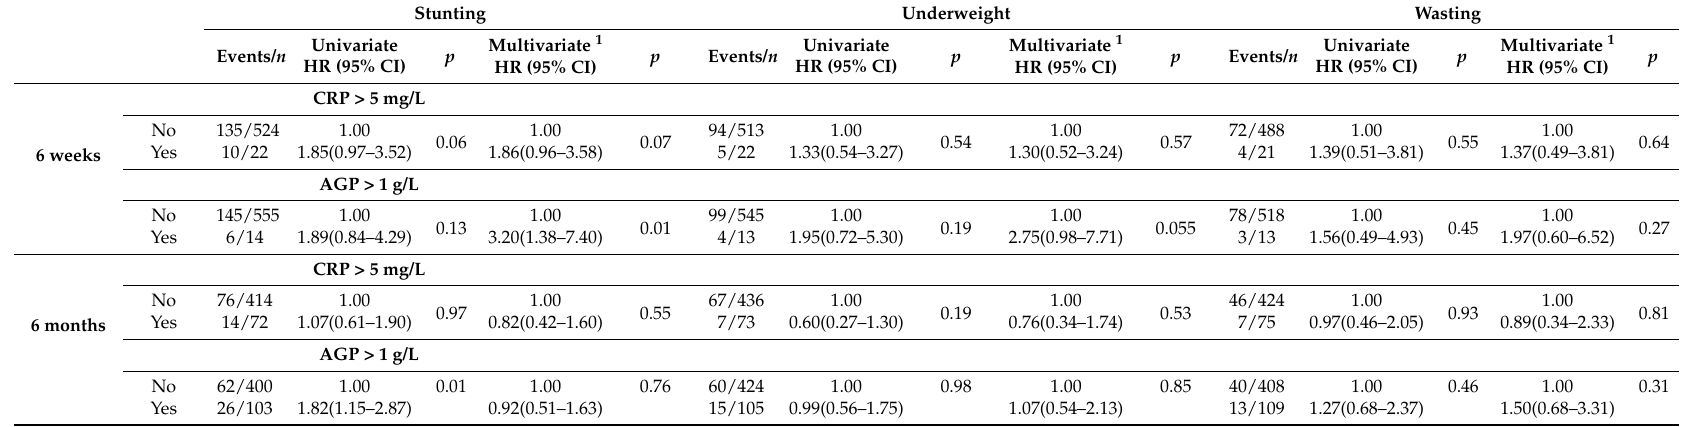
Table 5. Association of CRP and AGP biomarkers at 6 weeks and 6 months with subsequent stunting, wasting, and underweight. Stunting Underweight